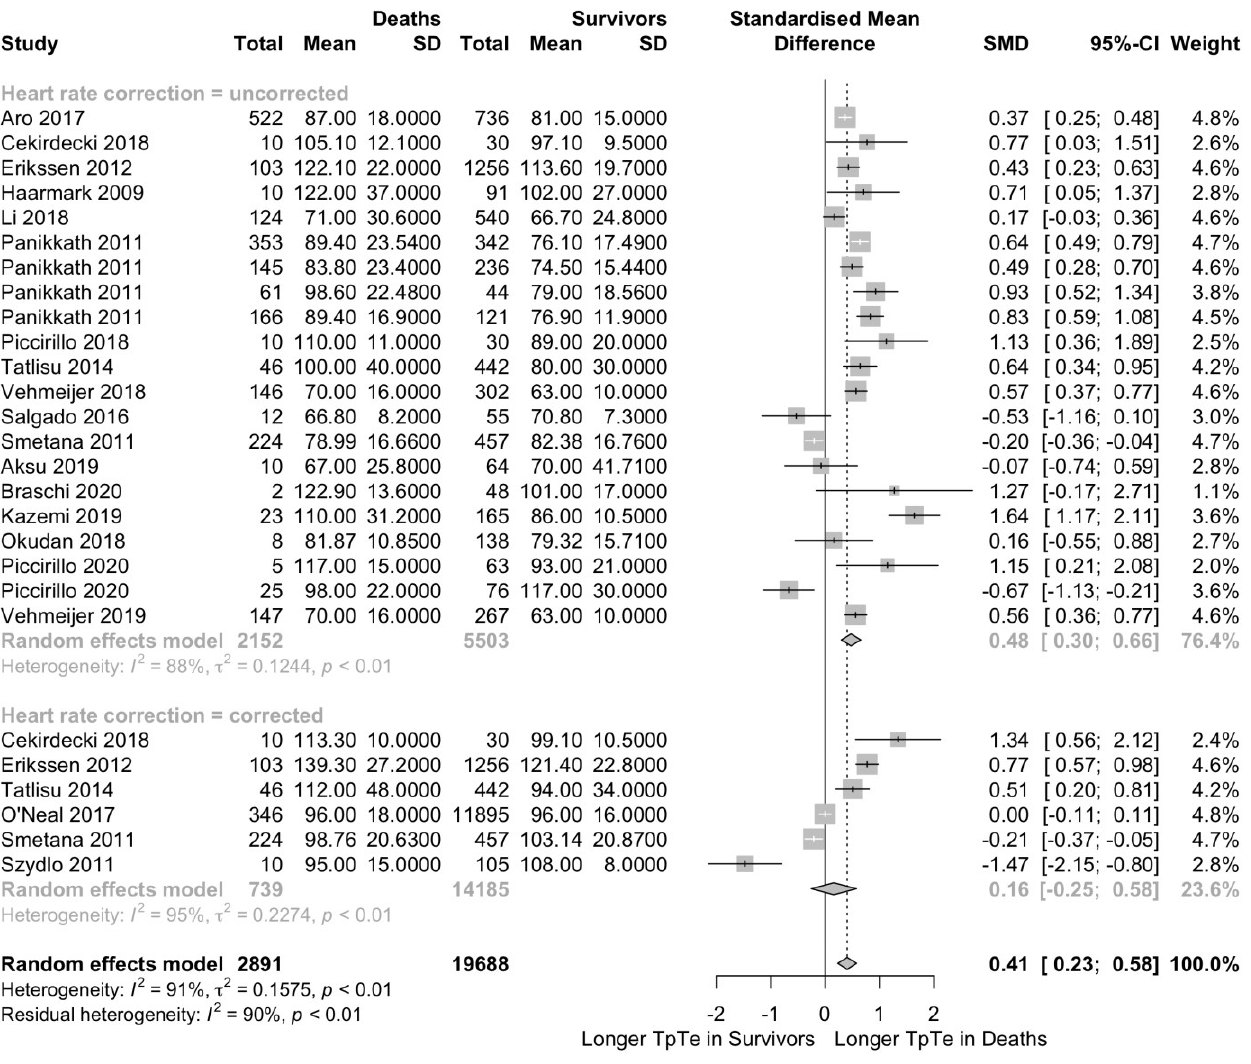
Figure 2. T peak -T end interval is longer in patients who died compared to survivors. The forest plot shows the data from 20,011 patients from 21 studies, comparing the T peak -T end interval in deaths and survivors. Patients who died had a longer T peak -T end interval by a standard mean difference (SMD) of 0.41. T p T e = T peak -T end interval; SD [25,27,29 – 32,34,35,37,39 – 43,46,49,51 – 53].